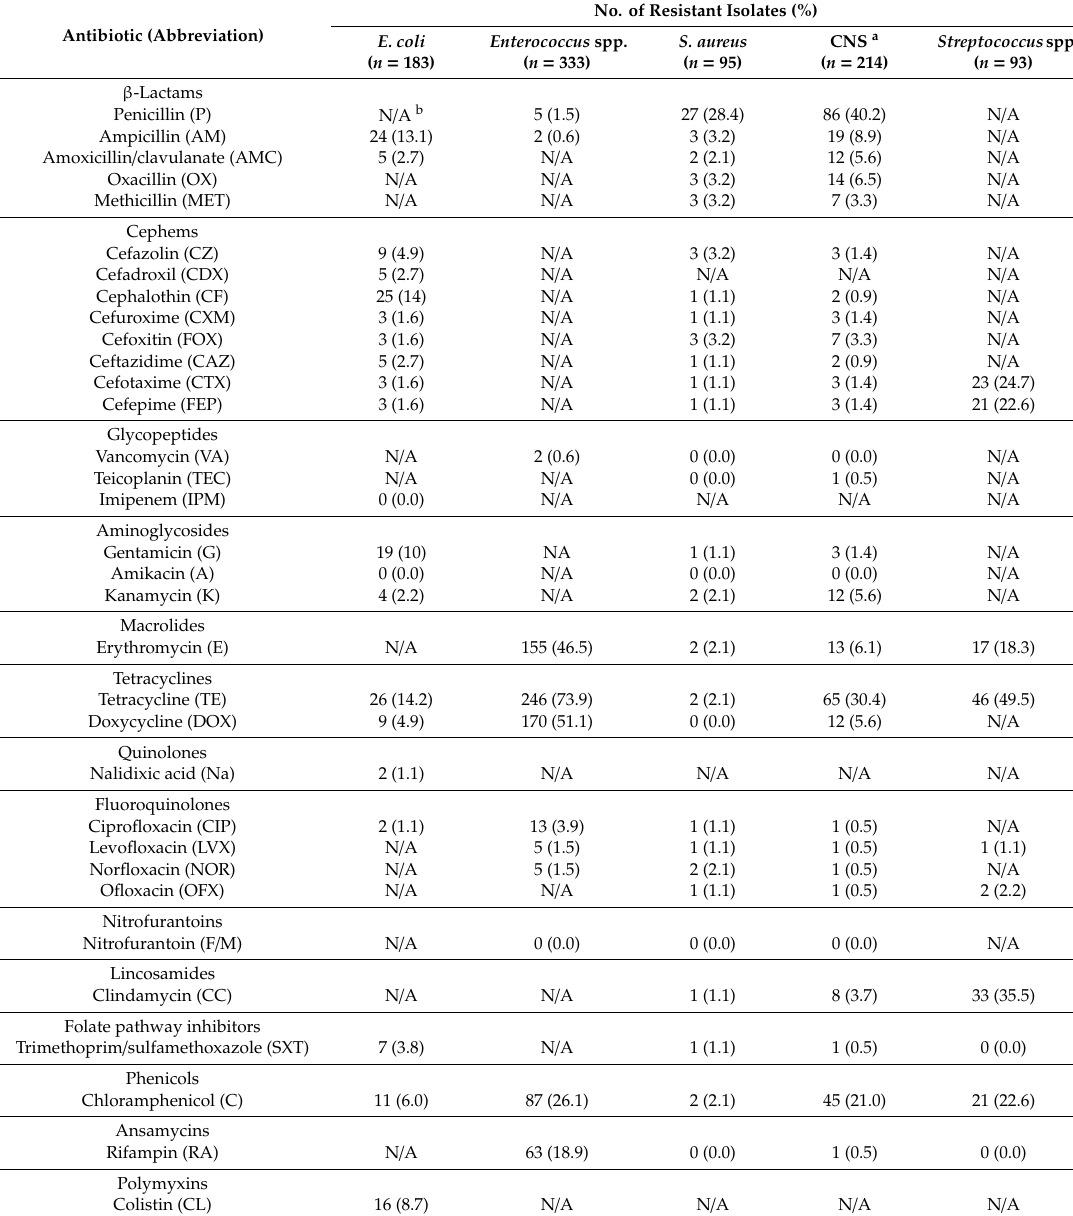
Table 4. Antimicrobial resistance in 918 pathogens isolated from bulk tank